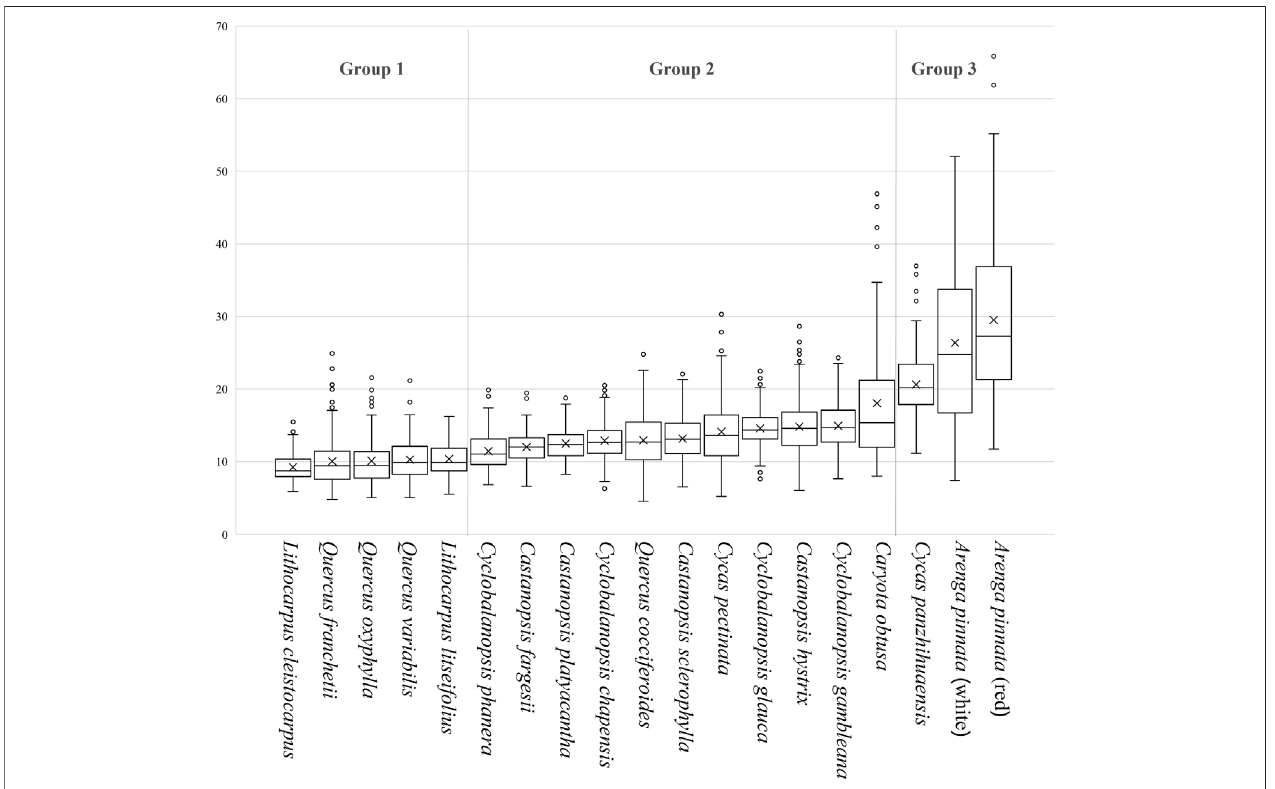
FIGURE 3 | Box plot of the granule sizes of the starches examined.